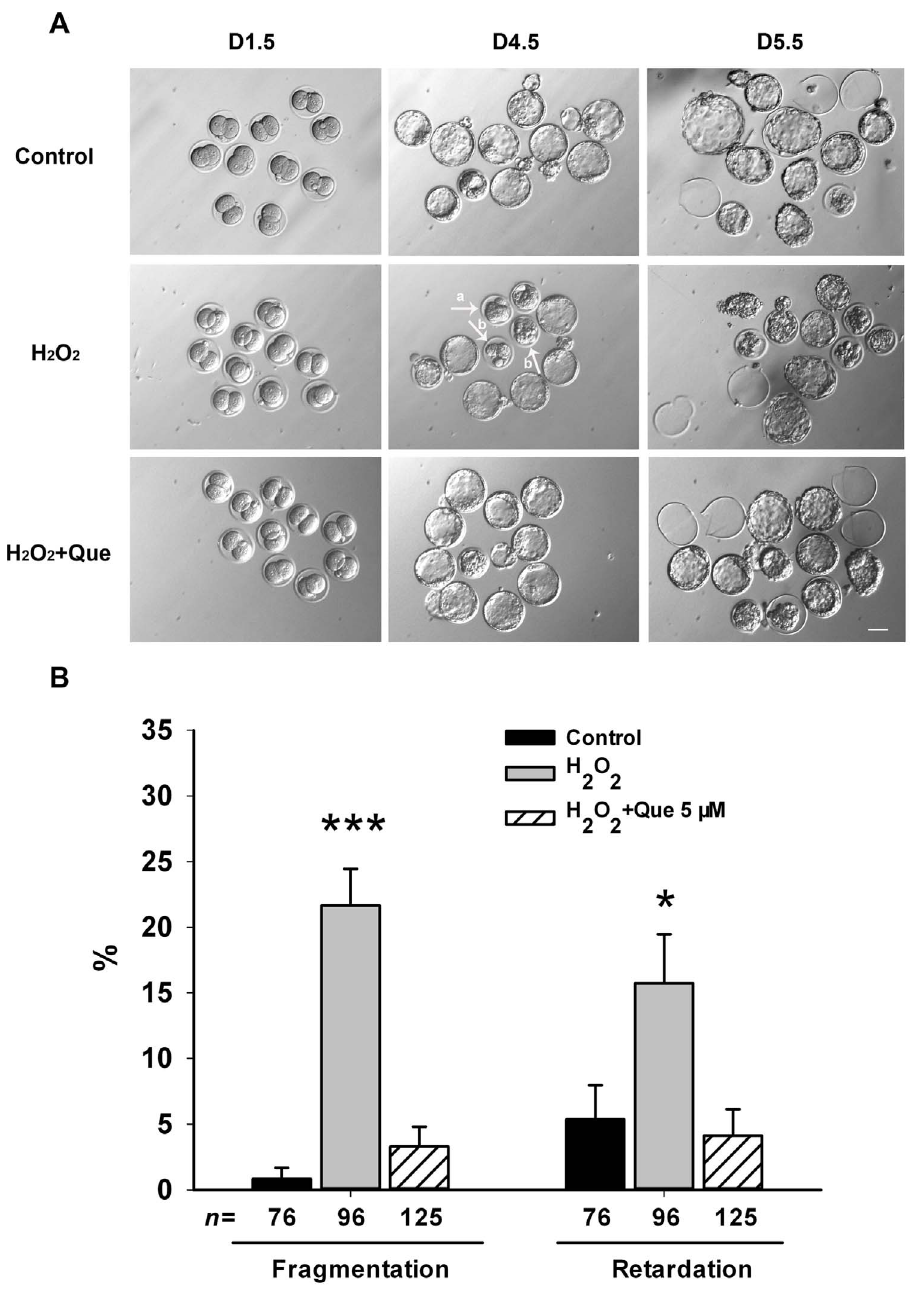
Figure 1. Quercetin prevented H 2 O 2 -induced fragmentation and retardation in blastocysts. (A) Representative images of pre- implantation embryos cultured in the presence or absence of quercetin (Que) under H 2 O 2 -induced oxidative stress. Zygotes were pre-treated for 3 h with 5 m M Que followed by addition of 35 m M H 2 O 2 for 15 min, and subsequently cultured in presence of Que until day 5.5. The morphology of pre- implantation embryos was imaged at D1.5 (2-cell), D4.5 (blastocyst) and D5.5 (hatched) after fertilization. In the H 2 O 2 -treated group, developmental retardation (arrow a) and fragmentation (arrow b) were observed in blastocysts. Normal development and high embryo quality were apparent in the Que-treated group at 5 m M. Bar, 50 m m. (B) Quantification of fragmented and retarded blastocysts. Data are presented as the mean 6 SEM from three independent experiments. N shows the number of embryos and * P , 0.05; *** P , 0.001, compared with the control group (One-way ANOVA). doi:10.1371/journal.pone.0089520.g001 cultured in media with quercetin or DMSO again until day 5.5. Zygotes of the control group were culture in KSOM continuously. Cleavage and embryo development were examined every 20–24 h until 5.5 days.